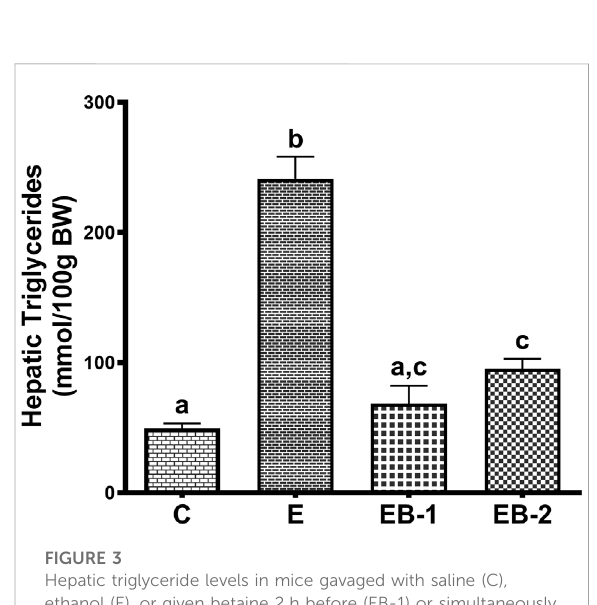
FIGURE 3 Hepatic triglyceride levels in mice gavaged with saline (C), ethanol (E), or given betaine 2 h before (EB-1) or simultaneously with the ethanol binges (EB-2). Data are presented as the mean ± SEM ( n = 5); values not sharing a common letter signi fi cantly differ from each other at p ≤